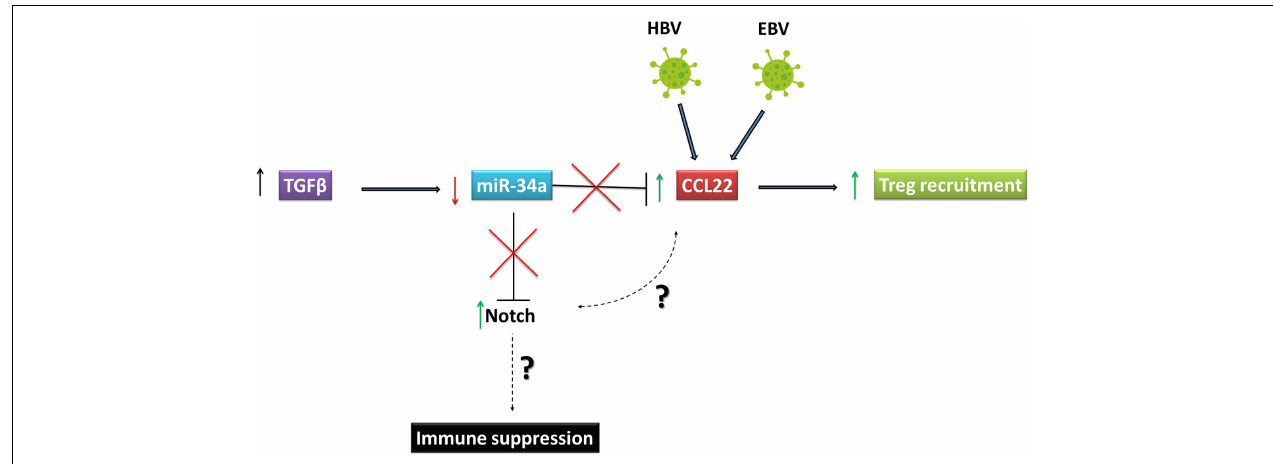
FIGURE 3 | Oncoviruses exploit Notch signaling to escape immune responses. Reed Sternberg cells, which represent the Hodgkin’s Lymphoma tumor component are high expressers of Notch 1 and 2 and produce high levels of CCL22. This chemokine is important for recruiting regulatory T (Treg) cells to the tumor microenvironment. In HBV associated HCC, PVTT symptoms are positively correlated with TGF β . The increase in TGF β led to downregulation of miR-34a, which targets CCL22. Downregulation of miR-34a induced by TGF β in HCC led to an increase in CCL22 and consequently in regulatory T cell recruitment to create an immunosuppressive tumor environment. HBV, Hepatitis B virusVirus; EBV, Epstein Barr Virus; HCC, Hepatocellular